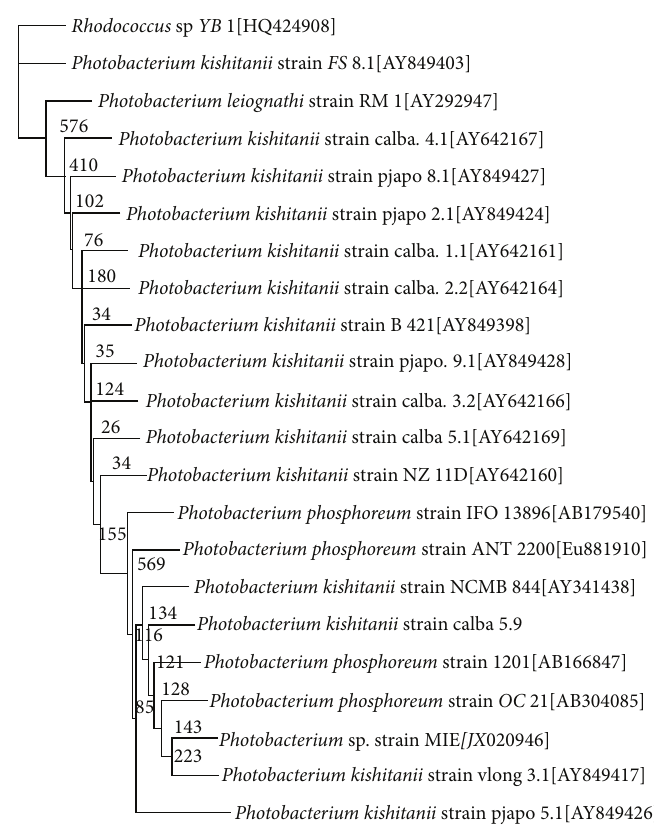
Figure 1: Phylogram (neighbour-joining method) showing the genetic relationship between Photobacterium sp. strain MIE and other related references microorganisms based on the 16S rRNA gene sequence analysis from the GenBank database. Rhodococcus sp. is the outgroup. Species names were followed by the accession numbers of 16S rRNA. The internal labels at the branching points refer to bootstrap value. Scale bar represents 100 nucleotides substitution.